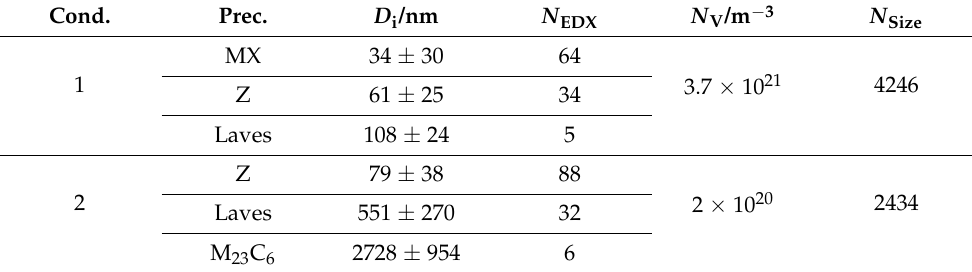
Table 5. Precipitate sizes and number densities from Z6 TEM analysis. Cond. Prec. D i /nm N EDX N V /m −